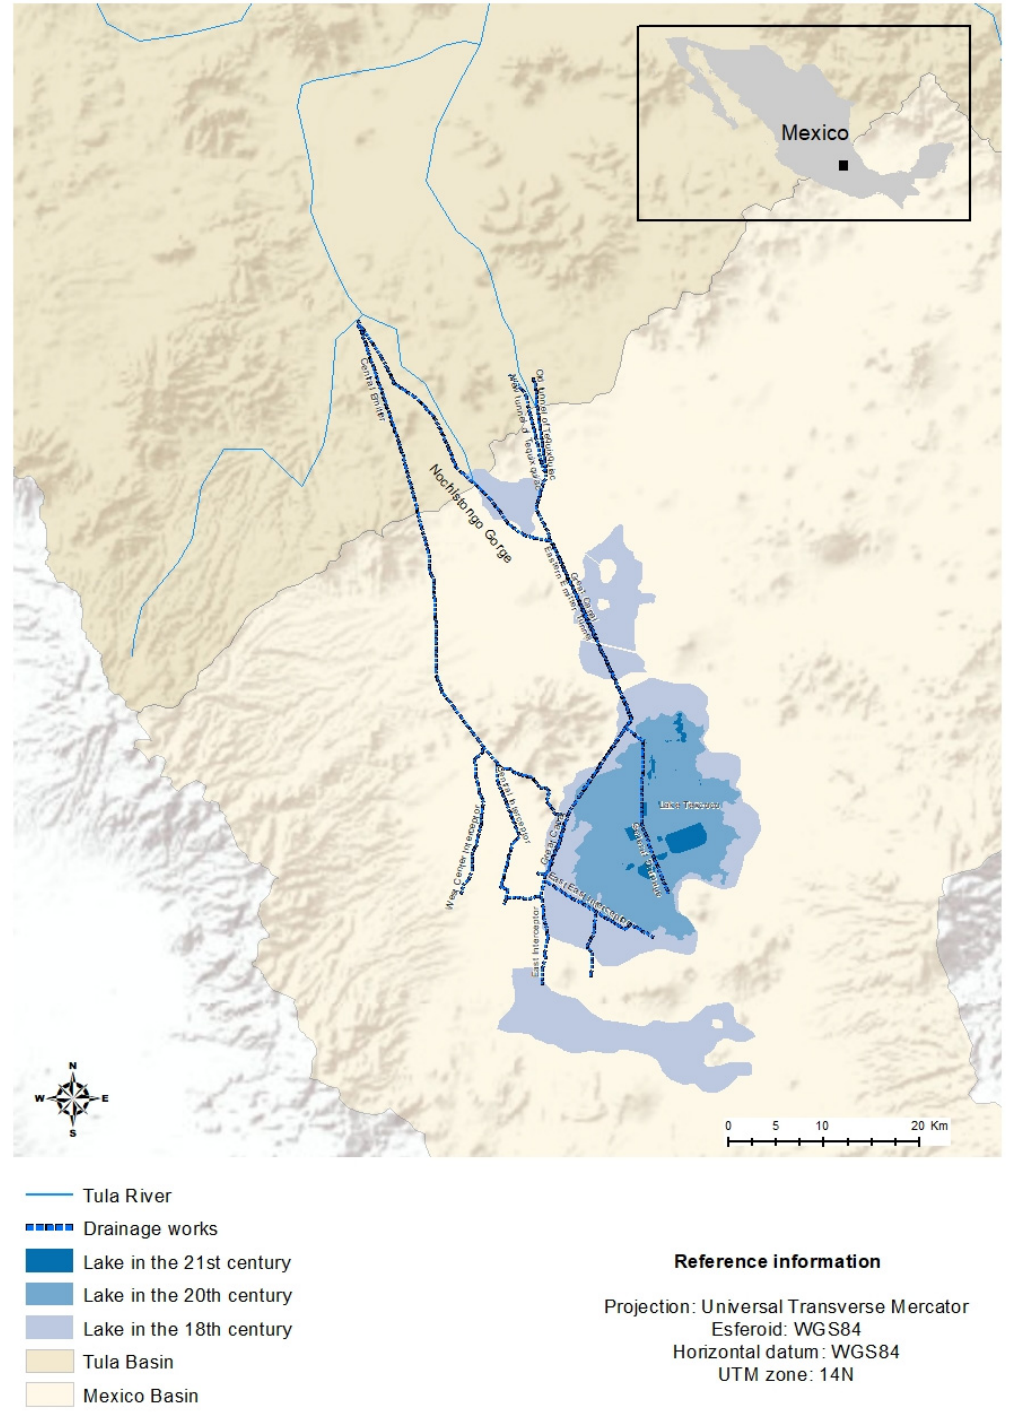
Figure 2. Hydrotechnical works that open Mexico Basin to Tula Basin. Own elaboration based on data from CONABIO [42] and Stangl [43], historical maps recovered from Mapoteca Orozco y Berra [44], and photo-interpretation of satellite images from